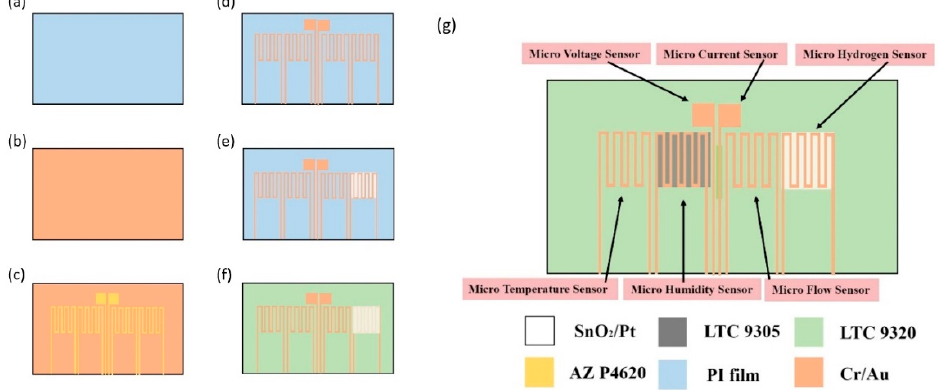
Figure 1. The process diagram of the flexible 6-in-1 microsensor.